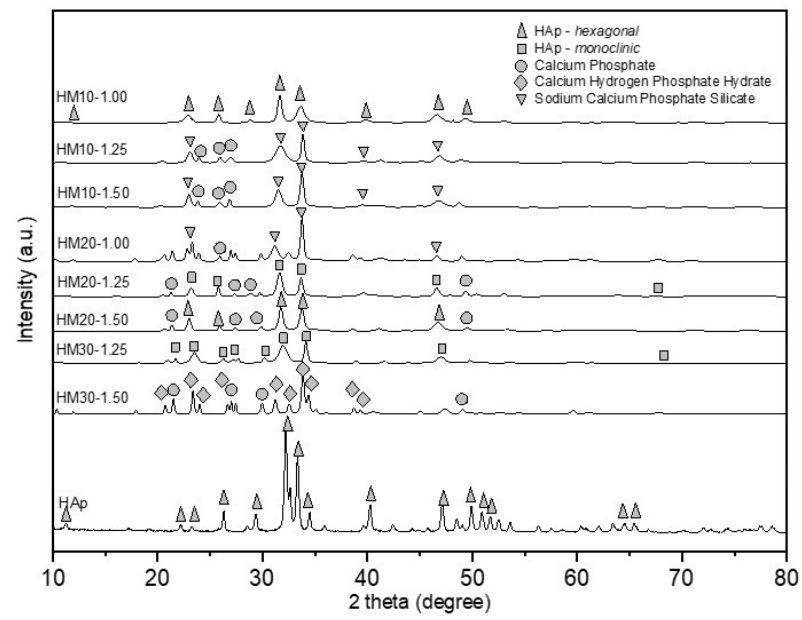
Figure 4. Phase diffractogram of mix design inputs of MK/HAp sintered at 900 °C. HM30-1.25 specimen indicates the formation of the monoclinic HAp phase through the peak’s determination at 23.49°, 31.95°, 34.12°, 46.98°, and 68.24° 2 θ (Powder Diffraction File-PDF No. 01-089-4405) [45]. To better elucidate the formation of the monoclinic